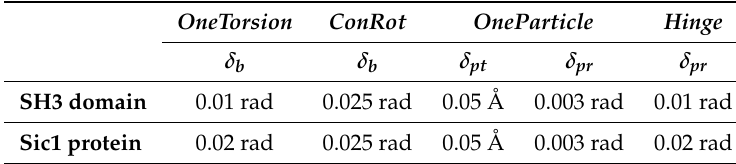
Table 1. Perturbation